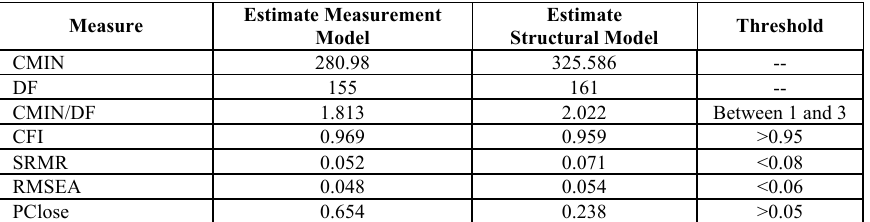
Table 3. Model goodness of fit measures